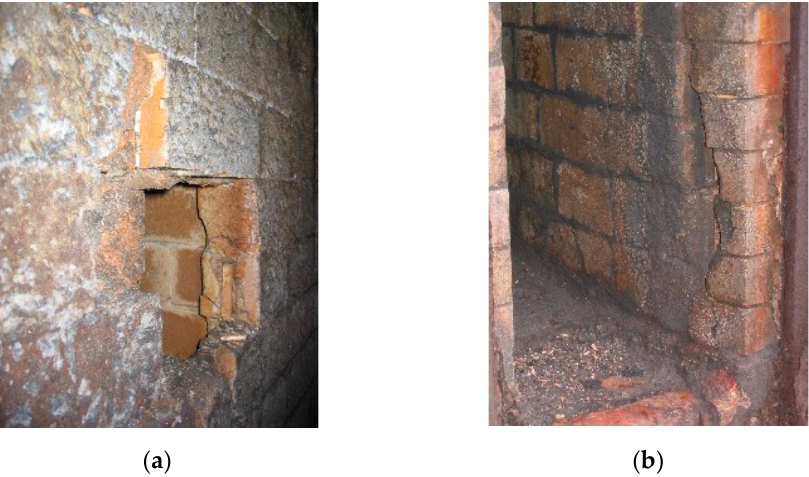
Figure 2. ( a ) Hole produced by hard pushes; ( b ) damage in the refractory produced by thermal shock.